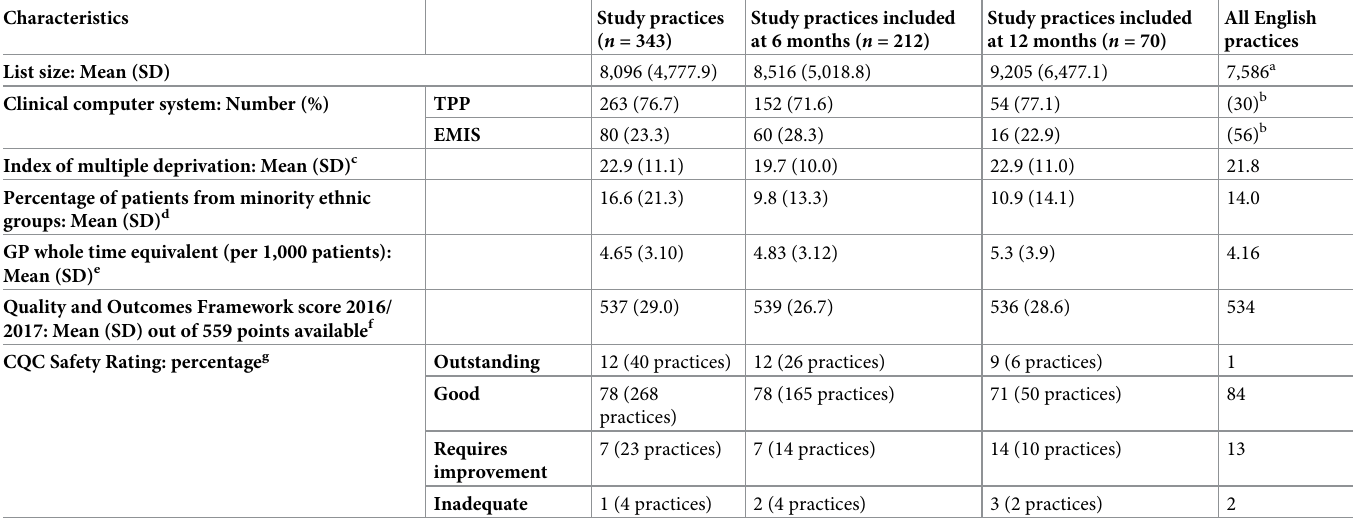
Table 2. Characteristics of 343 general practices in the East Midlands that implemented PINCER and were included in the analysis compared with English general practices overall.